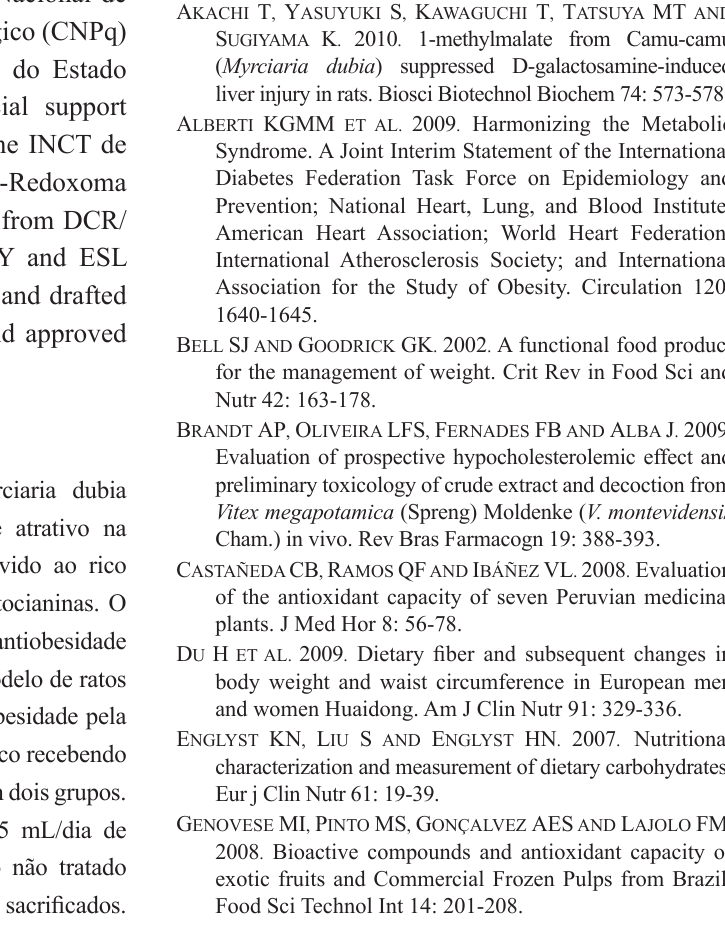
fígado. A polpa de Camu-camu foi capaz de melhorar